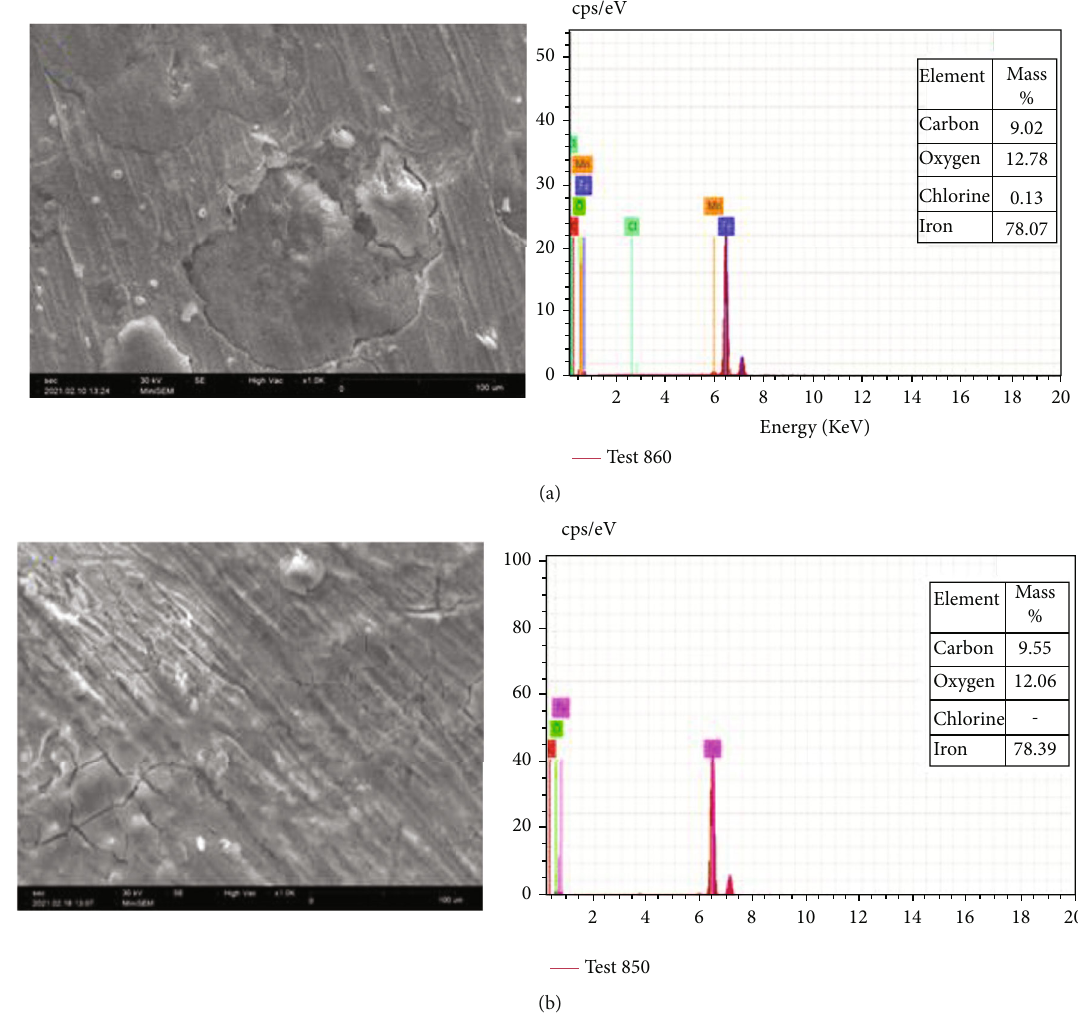
Figure 8: SEM-EDX micrographs of the mild steel surface: (a) in 1N HCl solution and (b) in 1N HCl solution with 250 ppm of 3-NA.